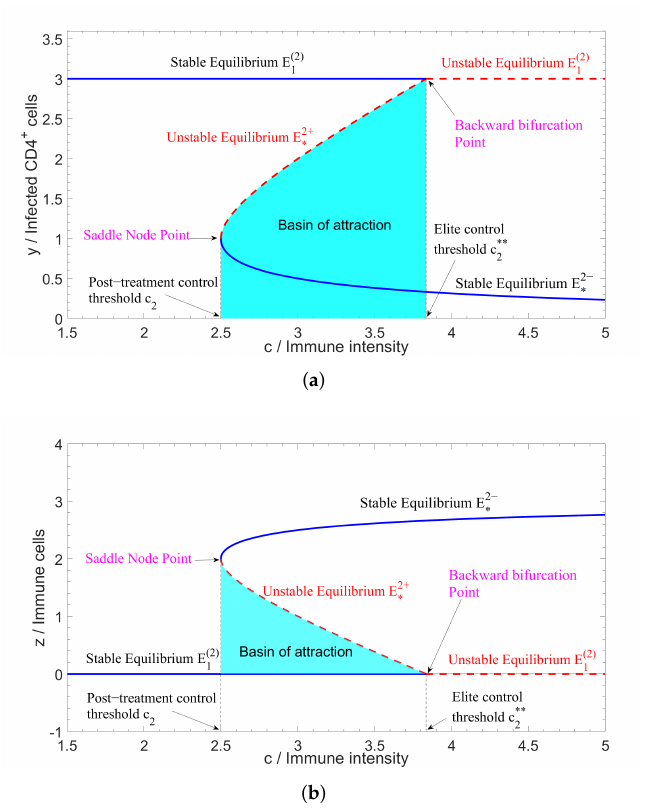
Figure 3. Bifurcation diagrams of system (2) where the vertical axis represents Infected CD4 + T cells (see ( a )) and Immune cells (see ( b )). The parameter values are listed in Table 4 and K = 6 cells/ µ L. The solid line represents stable equilibria, and the dotted line represents unstable equilibria. The post-treatment control threshold is c 2 ≈ 2.5, the elite control threshold c ∗∗ interval is ( 2.5,3.8333 )